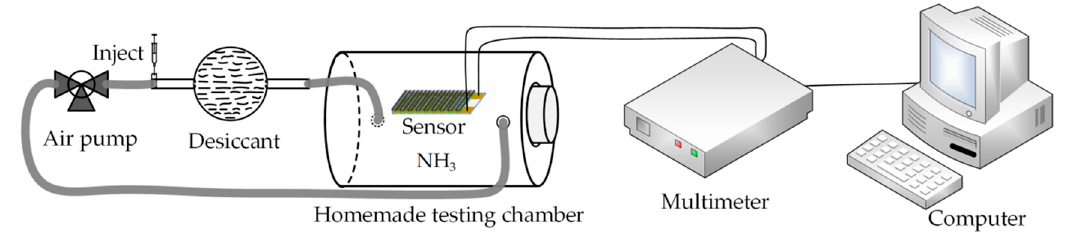
Figure 3. Schematic diagram of the gas sensing system.